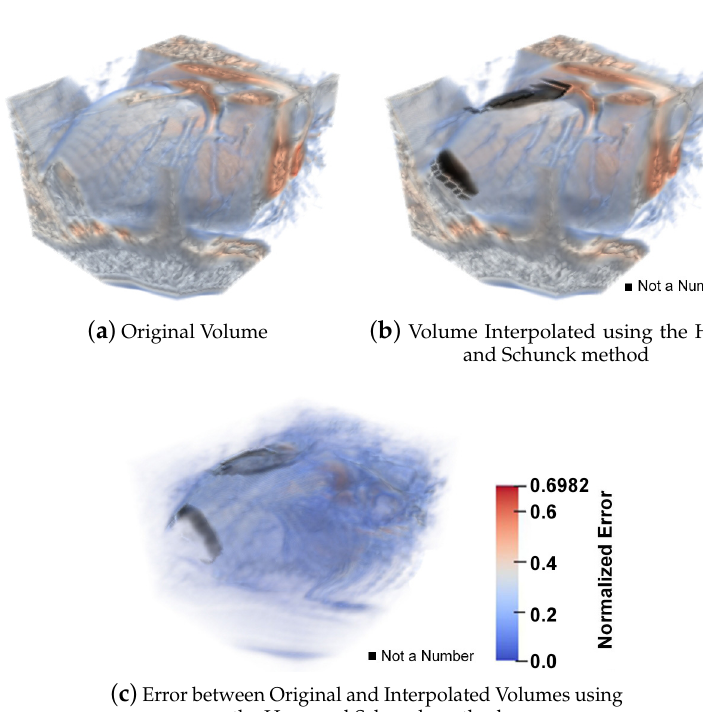
Figure 10. A cardiac CT volume showing the original volume, the interpolated volume using the 3D variant of the method of Sun et al. [20] and the error between the original volume and its interpolated